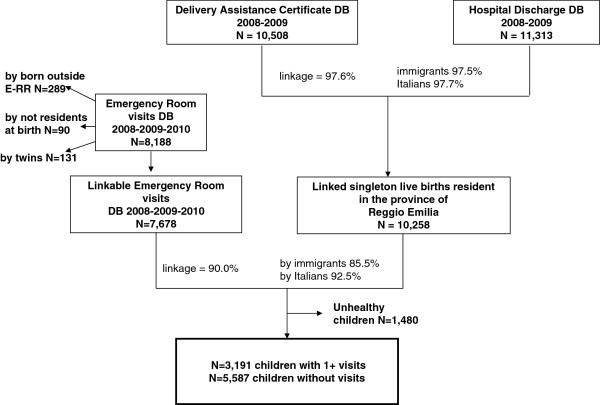
Record linkage process, flow chart, Reggio Emilia (Italy), 2008–2010.